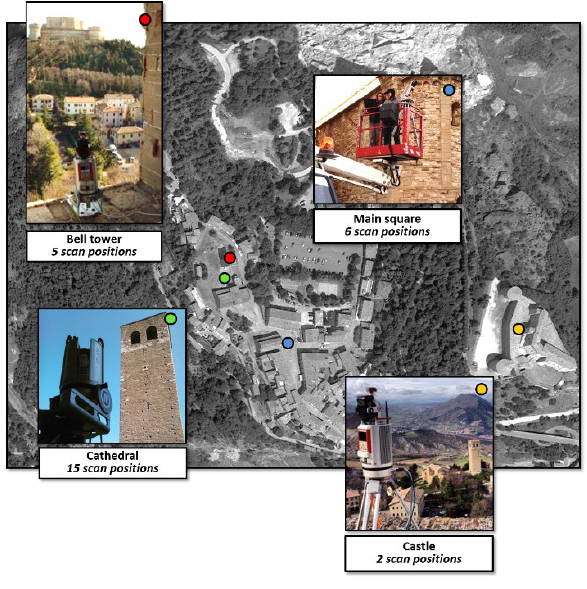
Figure 8. The area surveyed by the TLS, with in evidence the four points of acquisition.